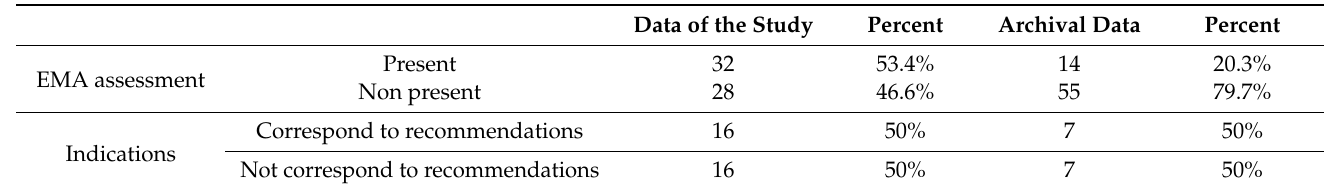
Table 1. A comparison with the EMA recommendations. Data of the Study Percent Archival Data Percent EMA